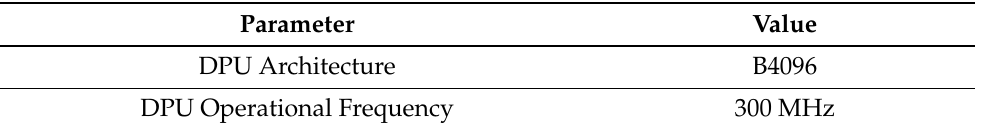
Table 4. Configuration parameters of the implemented DPU.